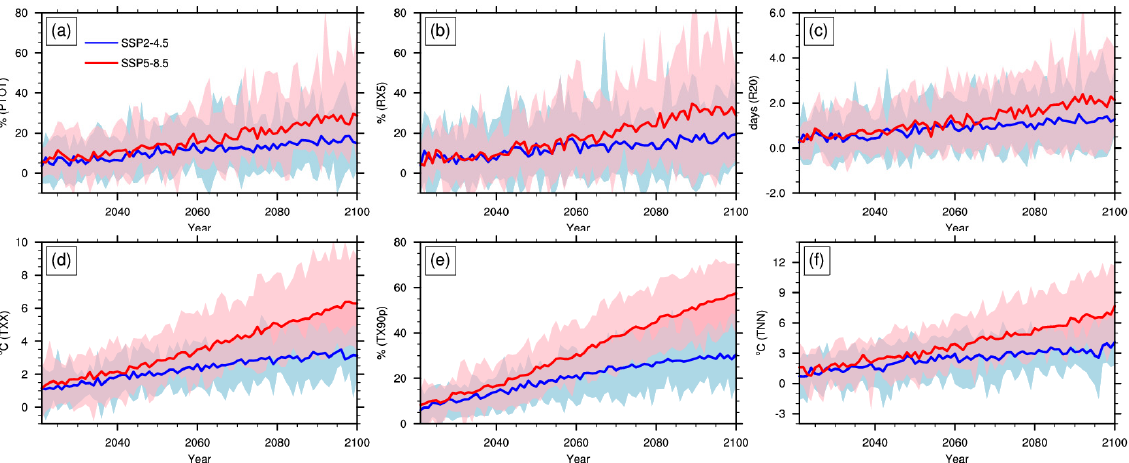
Figure 4. Projected changes in extreme climate indices of PTOT ( a ), RX5 ( b ), R20 ( c ), TXX ( d ), TX90P ( e ) and TNN ( f ) over China from 2021 to 2100 relative to baseline (1995–2014) based on downscaled dataset under scenarios SSP2-4.5 (blue) and SSP5-8.5 (pink) (shaded area represents for the range within maximum and minimum of the 13 models; lines are the multi-model ensemble means).